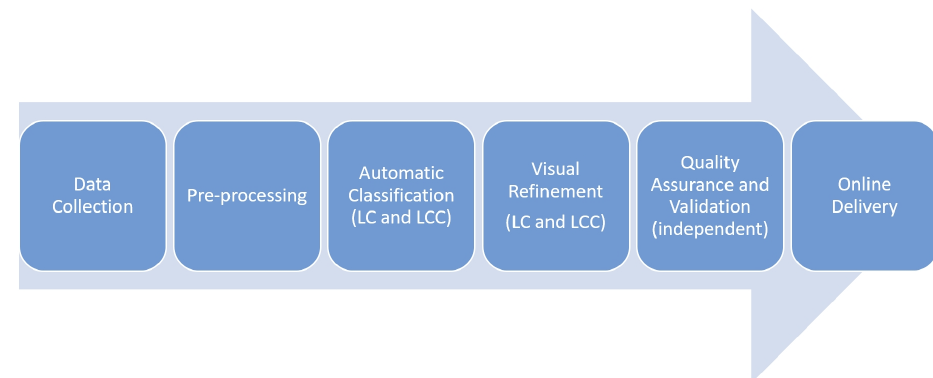
Figure 2. Overall production